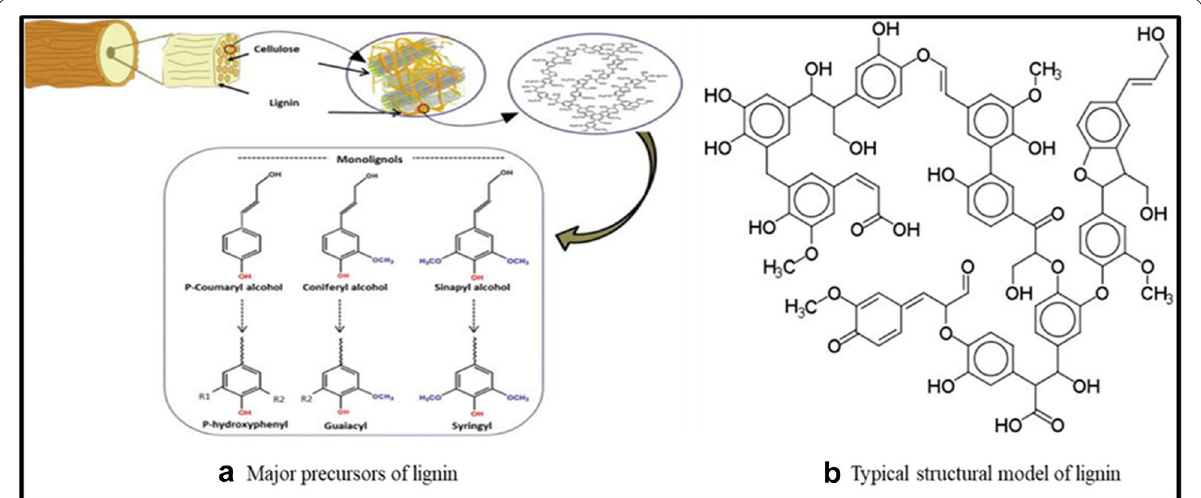
Fig. 8 Major precursors of lignin ( a ) typical structural model of lignin ( b